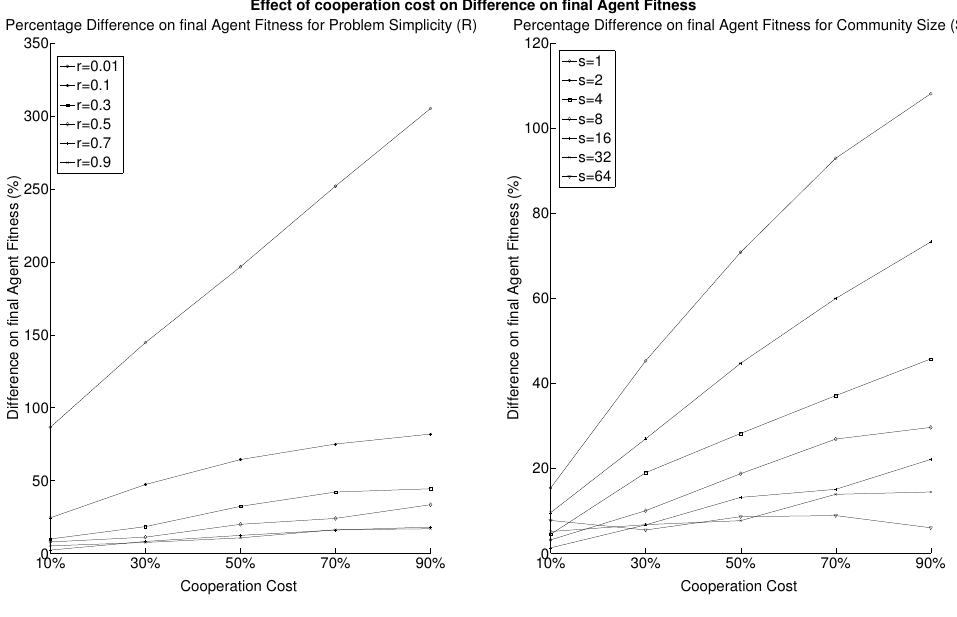
Figure 2. Percentage differences of the final agent fitness in comparison to the cost of cooperation, for each problem simplicity ( left plot) and for each group size ( right